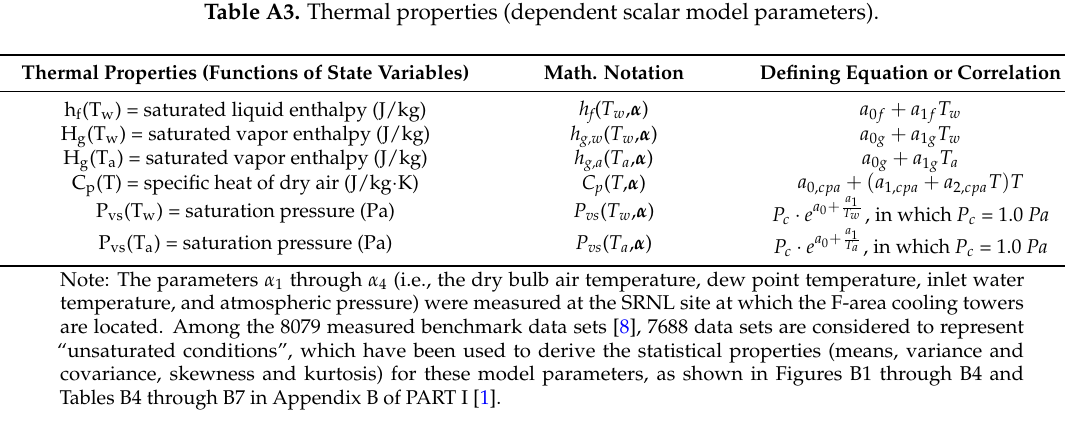
Table A3. Thermal properties (dependent scalar model